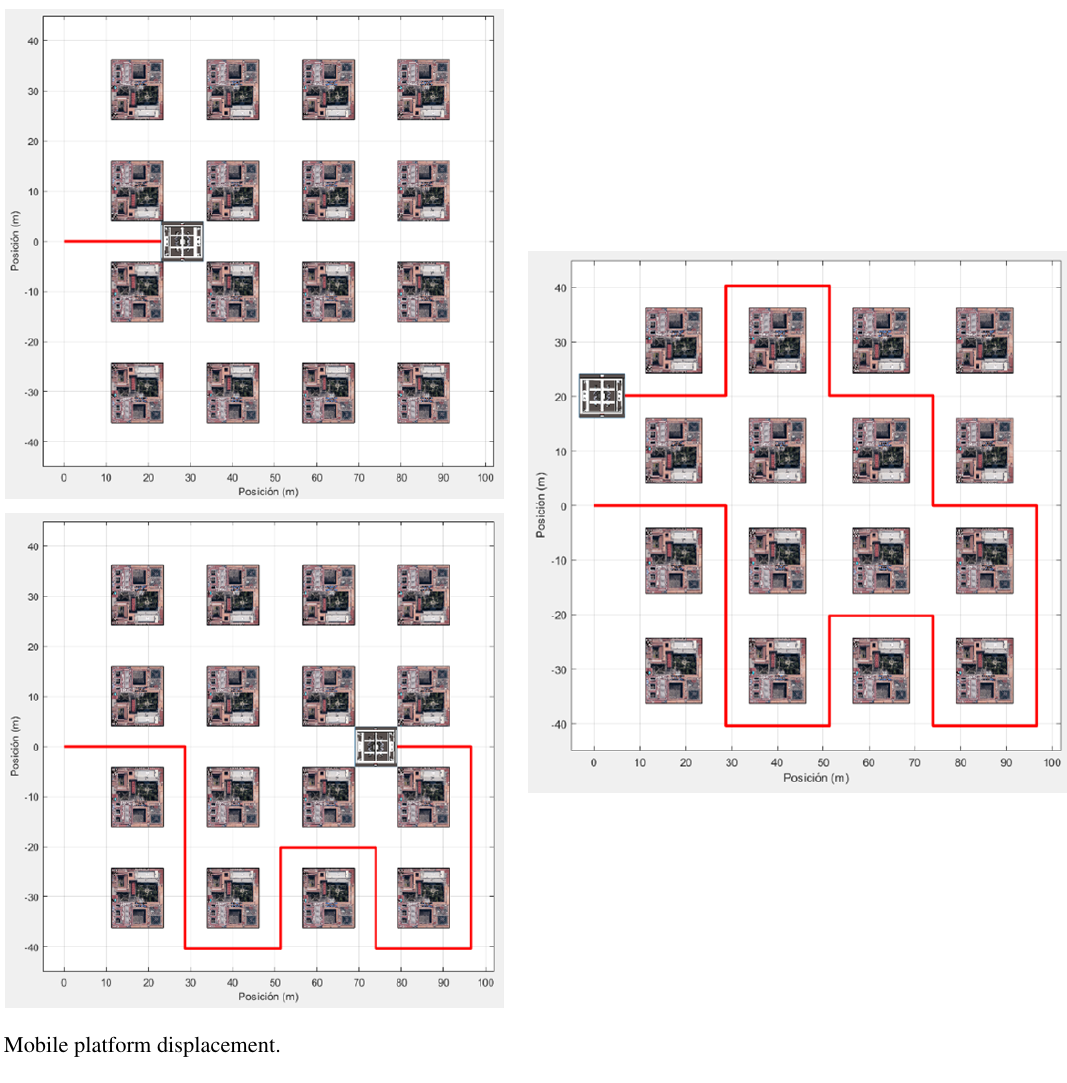
Figure 9. Mobile platform displacement.